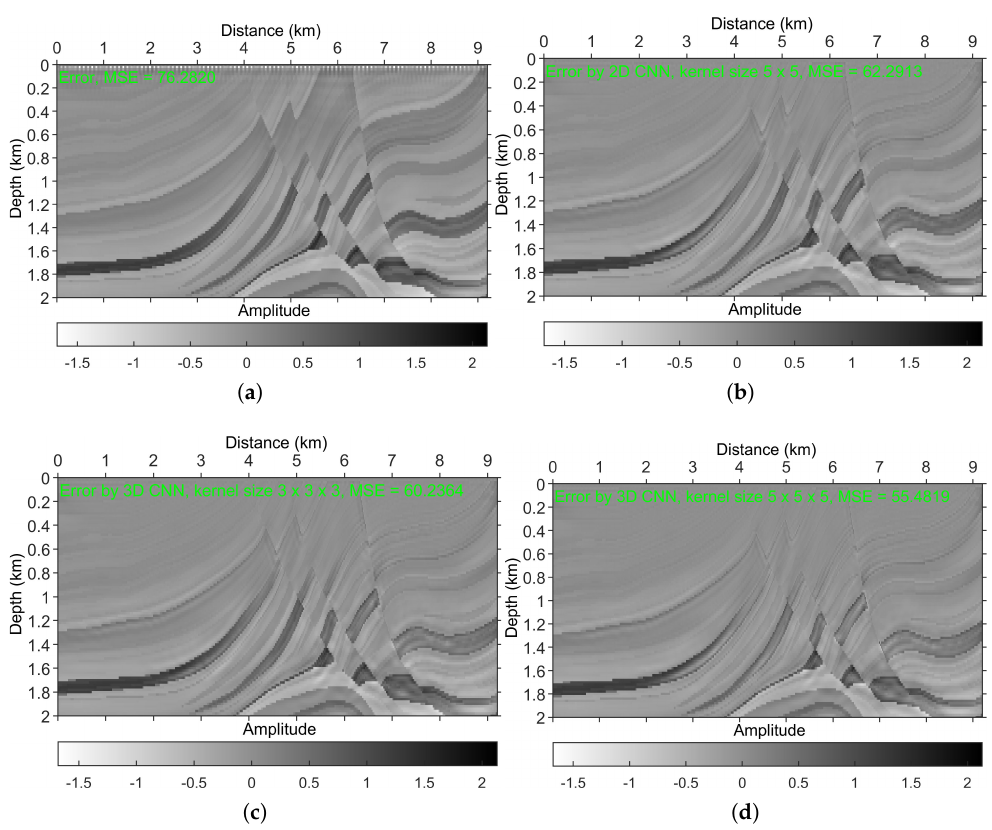
Figure 19. Difference plots for the result shown in Figure 18. ( a ) Difference plot for FWI result of using HF data only. ( b ) Difference plot for FWI result of using the DL-predicted low-frequencies by 2D CNN, where the kernel size is 5 × 5. ( c ) Difference plot for FWI result of using the DL-predicted low-frequencies by 3D CNN, where the kernel size is 3 × 3 × 3. ( d ) Difference plot for FWI result of using the DL-predicted low-frequencies by 3D CNN, where the kernel size is 5 × 5 ×